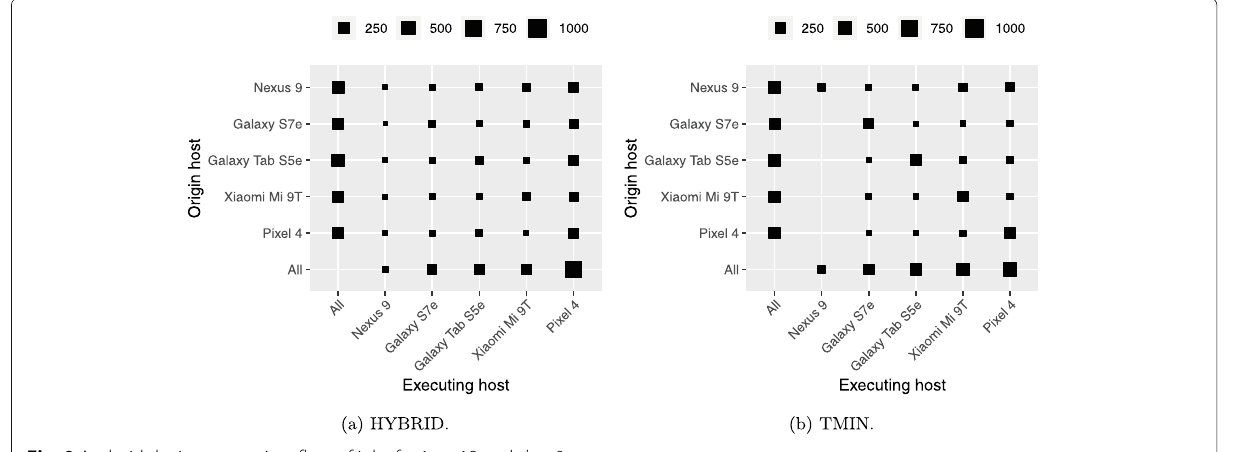
Fig. 9 Android devices scenario – flow of jobs for λ = 12 and d = 9